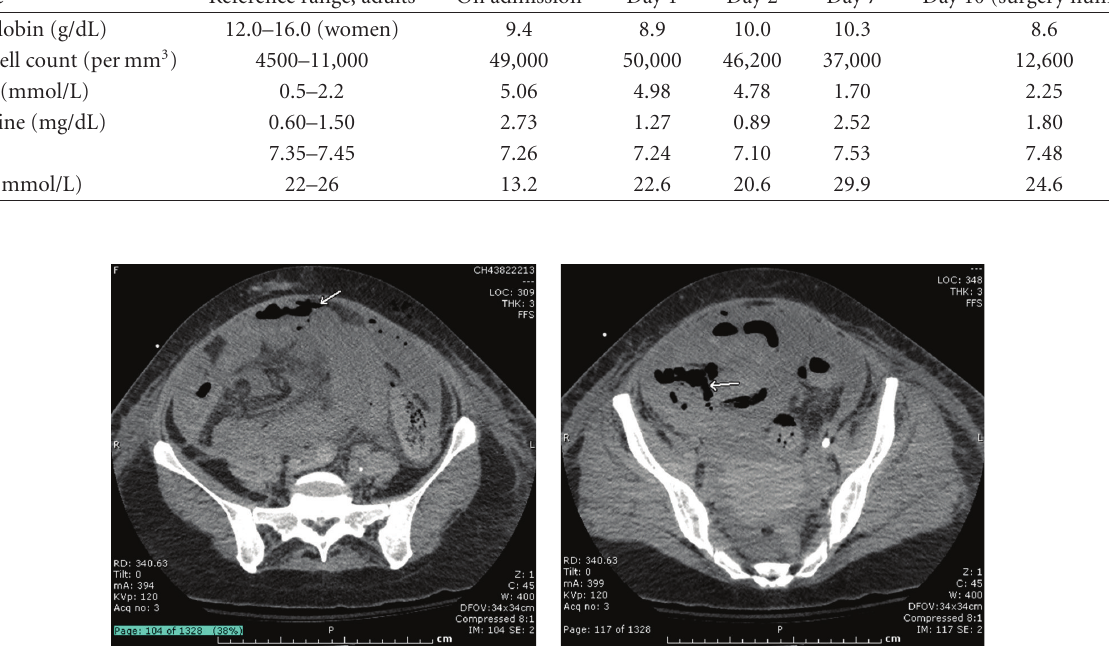
Figure 1: Pneumoperitoneum near the hypogastric region (a); with parietal pneumatosis of the caecum and sigmoid, compatible with acute ischemia